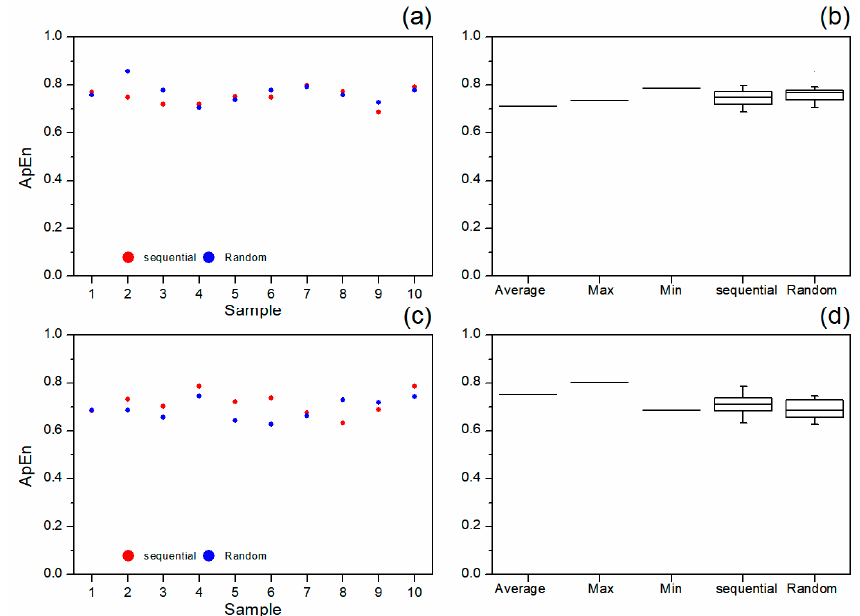
Figure 7. The ApEn values of 1-s observed wind speed obtained by the sequential order method and the random method (ten times) from 0.1-s time sequences for ( a ) d1 and ( c ) d2. The average and the box diagram of ApEn values of 1-s observed wind speed obtained by different sampling methods for ( b ) d1 and ( d ) d2.